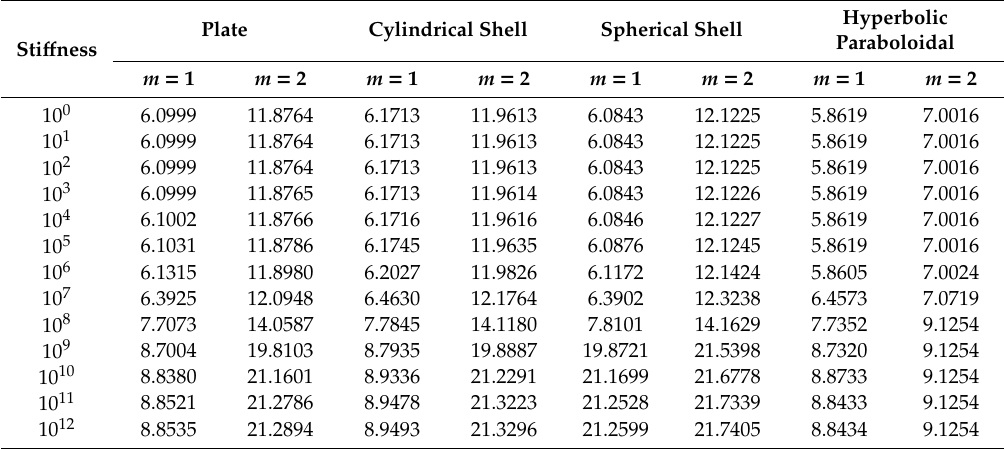
Table 14. The frequency parameter Ω for composite shallow [0 ◦ / 90 ◦ ] shells with S- K w boundary conditions by FSDT.